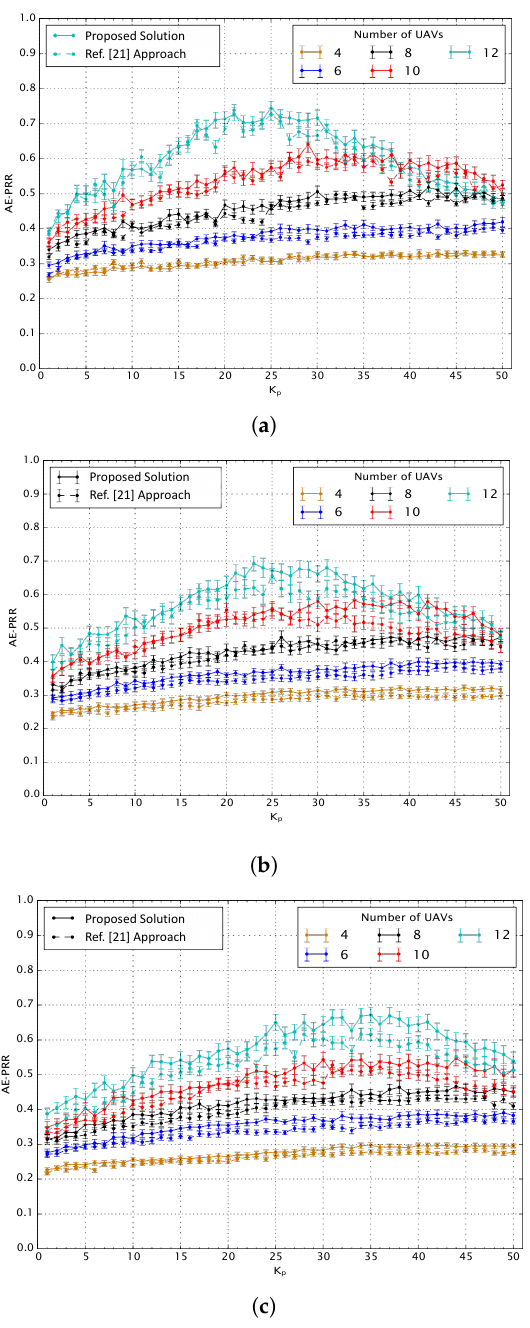
Figure 5. Average End-to-End Packet Reception Rate (AE-PRR) versus K p for ( a ) 3 teams of 20 GNs ( b ) 4 teams of 20 GNs ( c ) 5 teams of 20